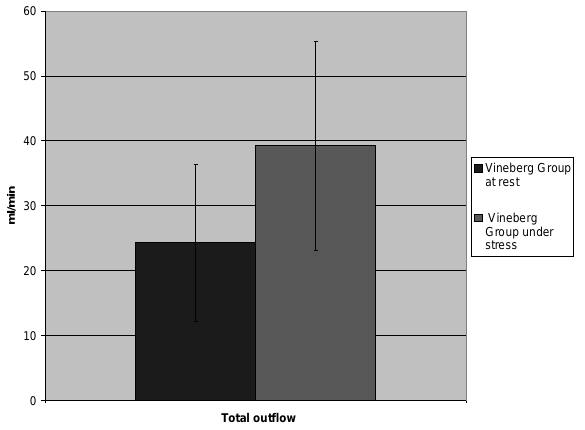
Fig. 4 - Mean total outflow values at rest and under stress of the Vineberg group. Increase of 61.8% (24.3 ± 12.1 ml/min versus 39.3 ± 16.1 ml/min;